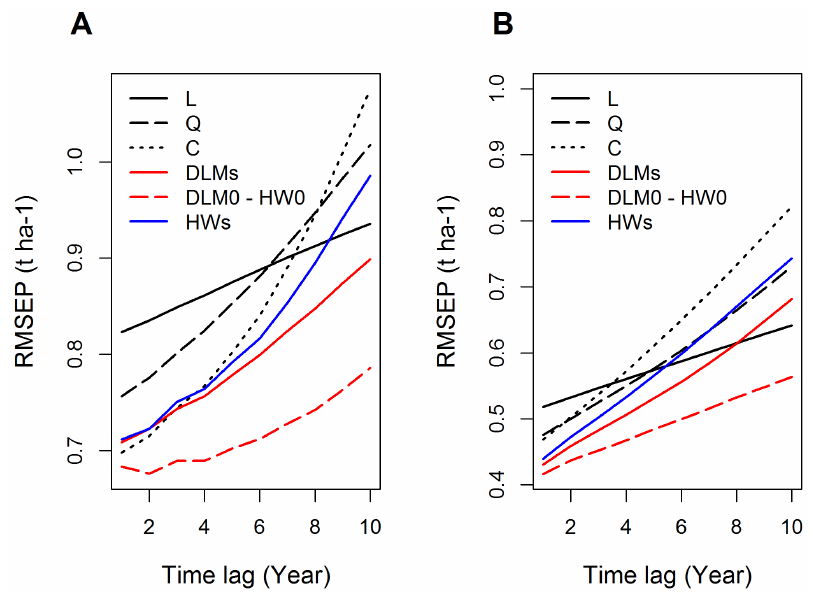
Figure 4. RMSEP of different statistical models as a function of time lag. A: France. B: Global.